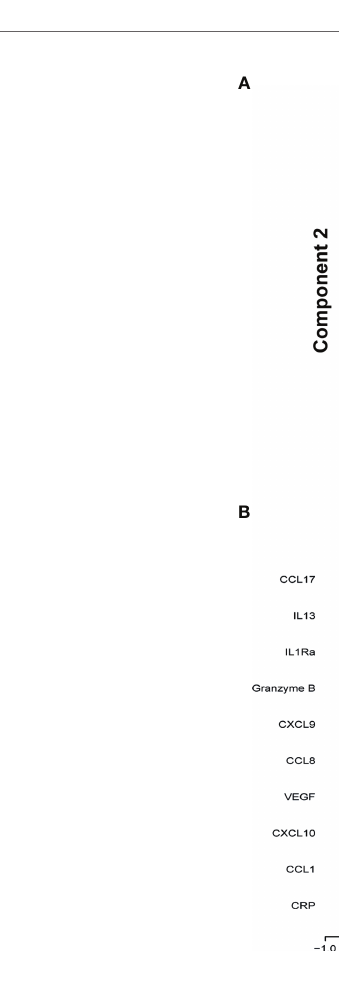
FIGURE 1 | Sparse partial least squares regression analyses of 40 cytokines measured in serum samples of individuals diagnosed with ATB and untreated LTBI. (A) Correlation circle plots representing the correlations between the cytokines and the fi rst two components of the sPLS. A correlation circle is a two-dimensional plot helping the interpretation of the correlations between the initial variables (i.e., the cytokines) and the new variables (i.e., the components) that are combinations of the fi rst ones: the closer a variable is to an axis and to the circle, the higher the correlation with the corresponding component will be. It is also a way to plot the correlations between the cytokines: if two cytokines are in opposite quarters, they are negatively correlated; if two cytokines are perpendicular, then their correlation is close to 0; if two variables are close, their correlation is close to 1. Top 10 cytokines of the fi rst two components are shown in the graph. GB, Granzyme B; I1, Il1Ra; 2, sIL2Ra; 9, CXCL9; I10, IL-10; I15, IL-15. (B) The contribution (i.e., the correlation) of the top 10 cytokines for components 1 and 2. The blue bars represent ATB, and the orange bars represent untreated LTBI. ATB, active tuberculosis; untreated LTBI, latent tuberculosis infection without prophylaxis; sPLS, sparse partial least